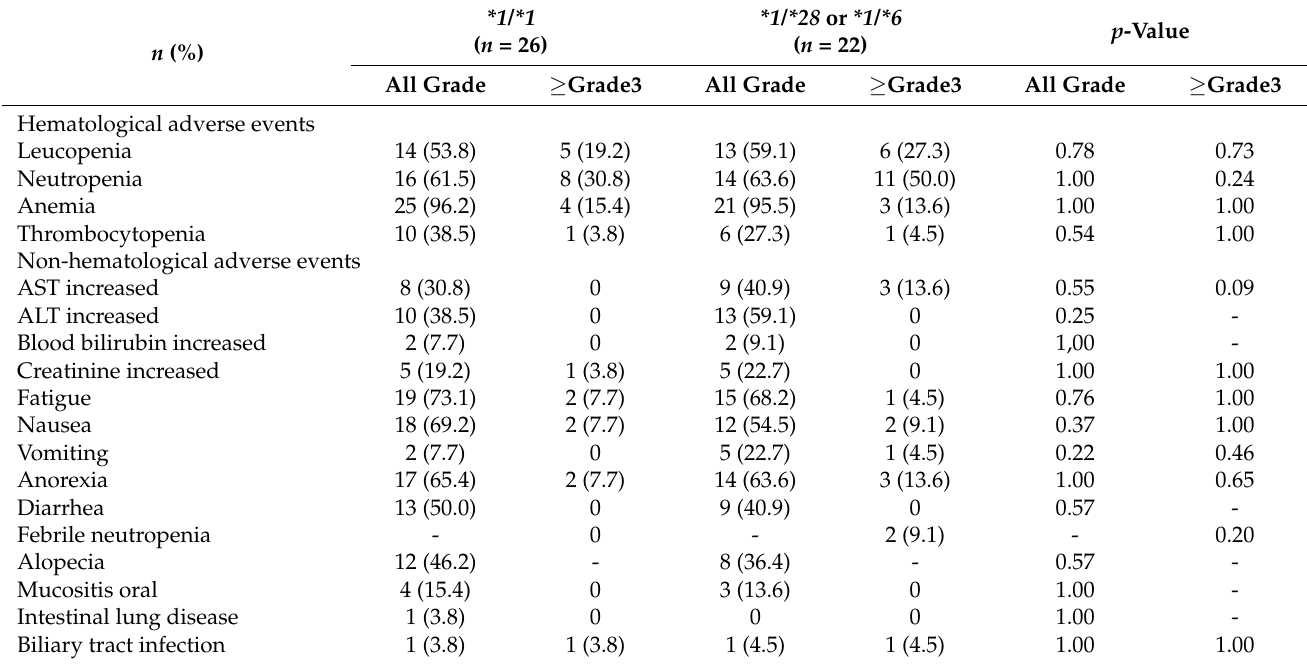
Table 5. Adverse events by UGT1A1 status.